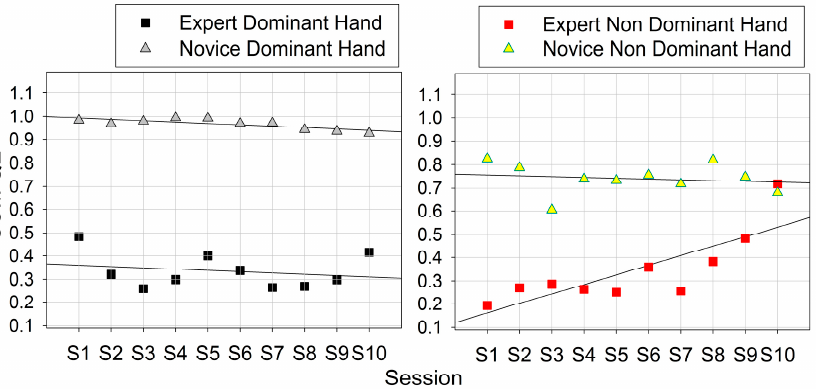
Figure 9. QE in the output of the brain-inspired neural network model (SOM) run on the grip-force data from the different sessions; the difference in grip-force variability between the expert and the novice is reliably predicted by the neural network map output metric.